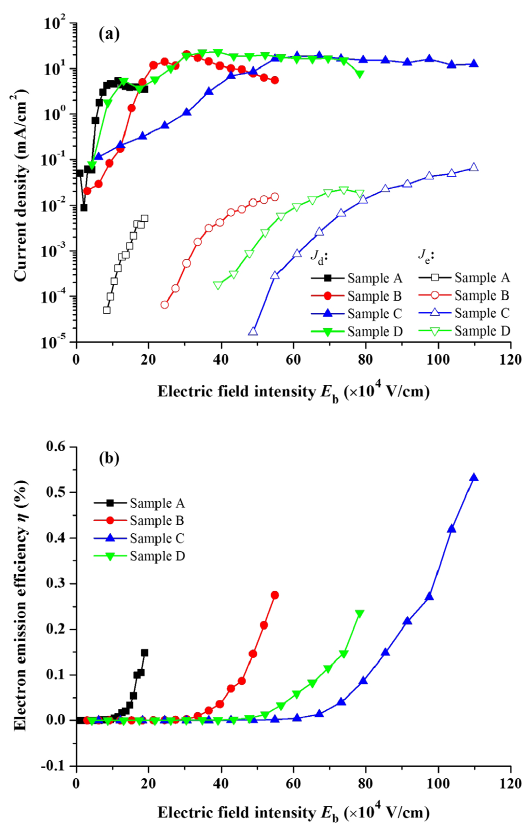
Figure 7. Dependences of (a) diode current density J current density J , and (b) emission efficiency η on electric field e intensity E